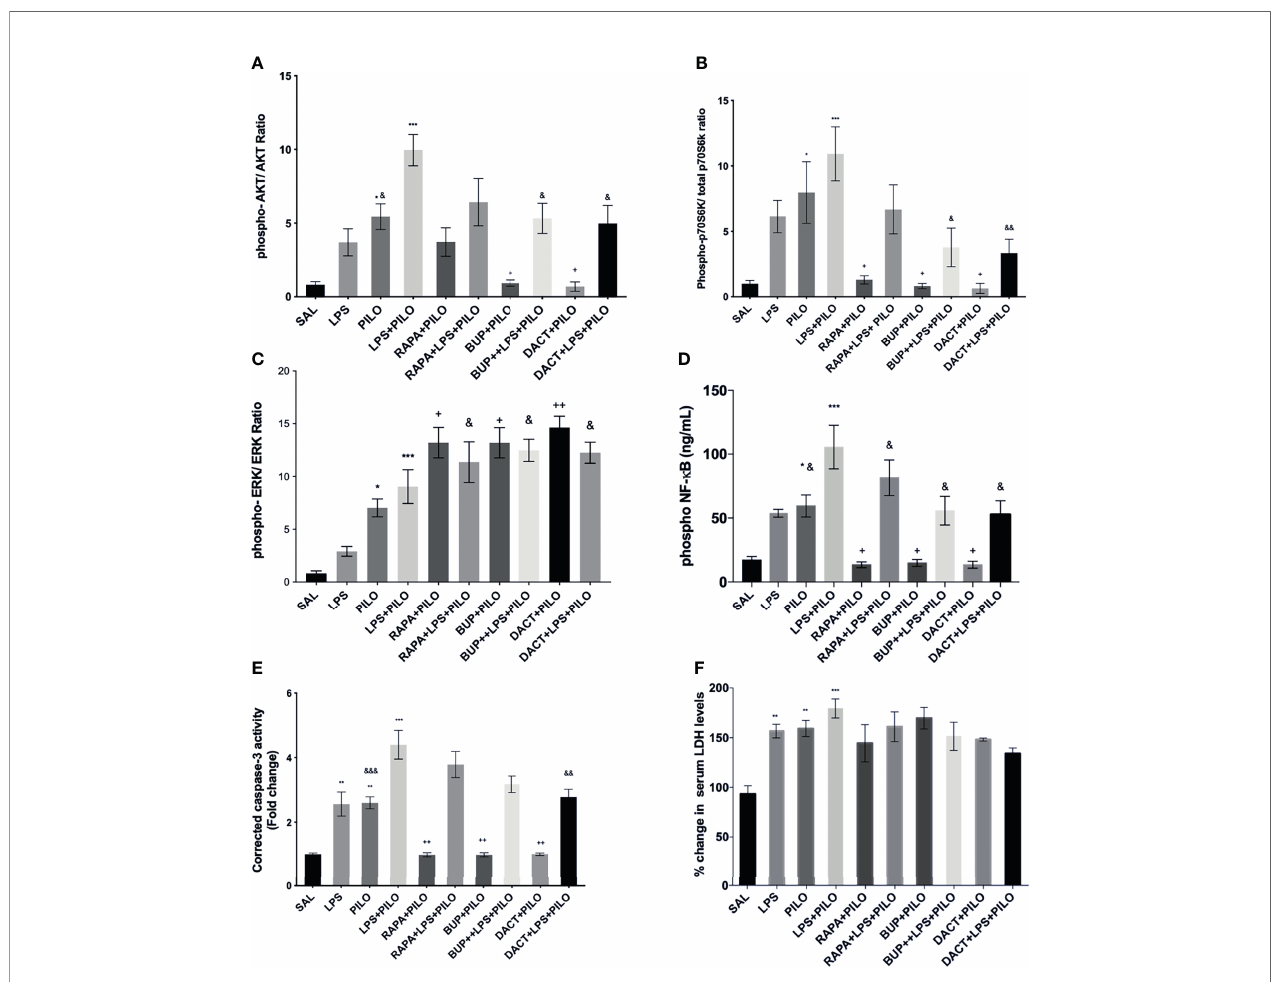
FIGURE 7 | RAPA, BUP, and DACT alter PI3K pathway protein pro fi le. Graphs show differential protein levels due to different treatments. (A) Hippocampal phospho-Akt/Akt, (C) hippocampal phospho-p70S6K/total-p70S6K, (B) hippocampal phospho-ERK/ERK, (D) hippocampal phospho-NF- k B levels (ng/mL), (E) corrected caspase-3 activity in mice hippocampus, and (F) serum LDH levels in C57BL/6 mice with or without LPS priming in the PILO model. Data are represented as mean ± SEM; n=3. The signi fi cance is ascertained as ***p<0.001 versus SAL, **p<0.01 versus SAL, *p<0.05, ++ p<0.01 versus PILO, + p<0.05 versus PILO, && p<0.01 versus LPS+PILO, and & p<0.05 versus